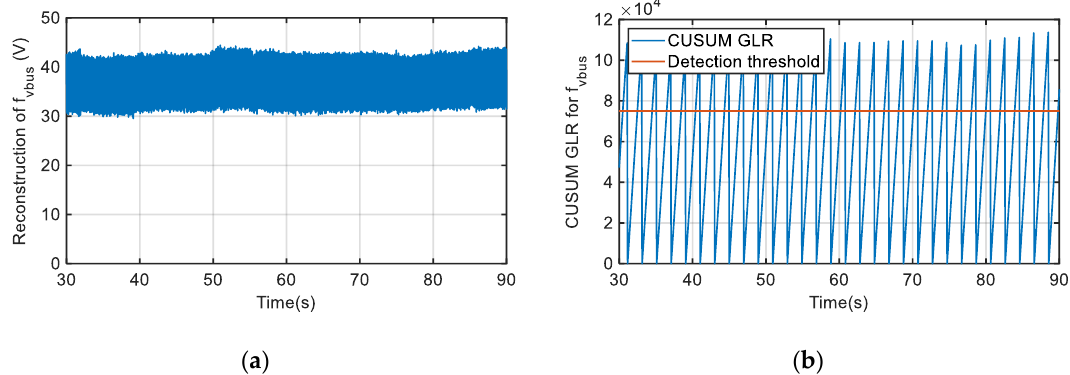
Figure 14. Gain fault injection in DC-link voltage sensor. ( a ) DC-link voltage sensor fault reconstruction. ( b ) CUSUM GLR calculation.